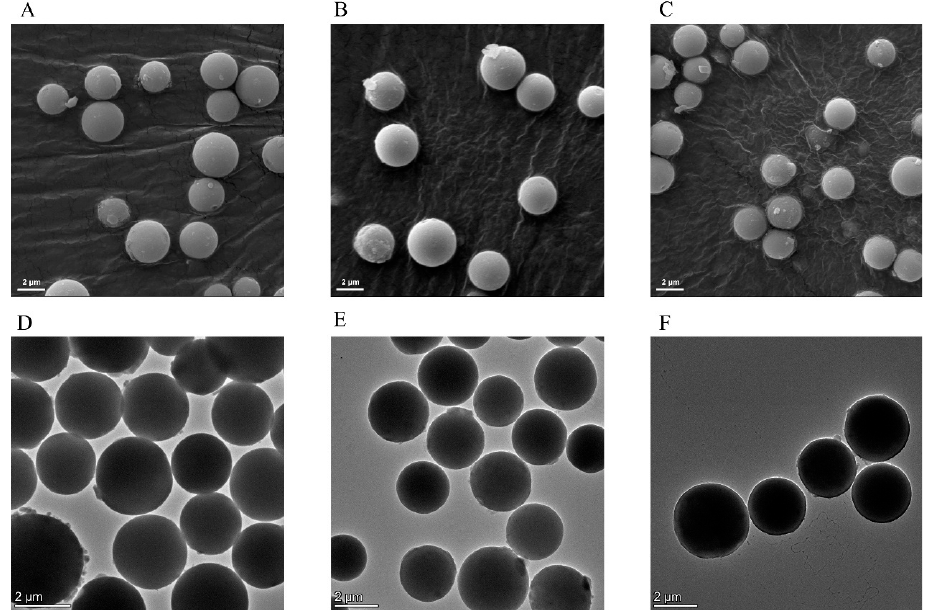
Figure 3. SEM micrographs of bare active silica gel ( A ), SiO 2 @NH 2 @COOH ( B ),